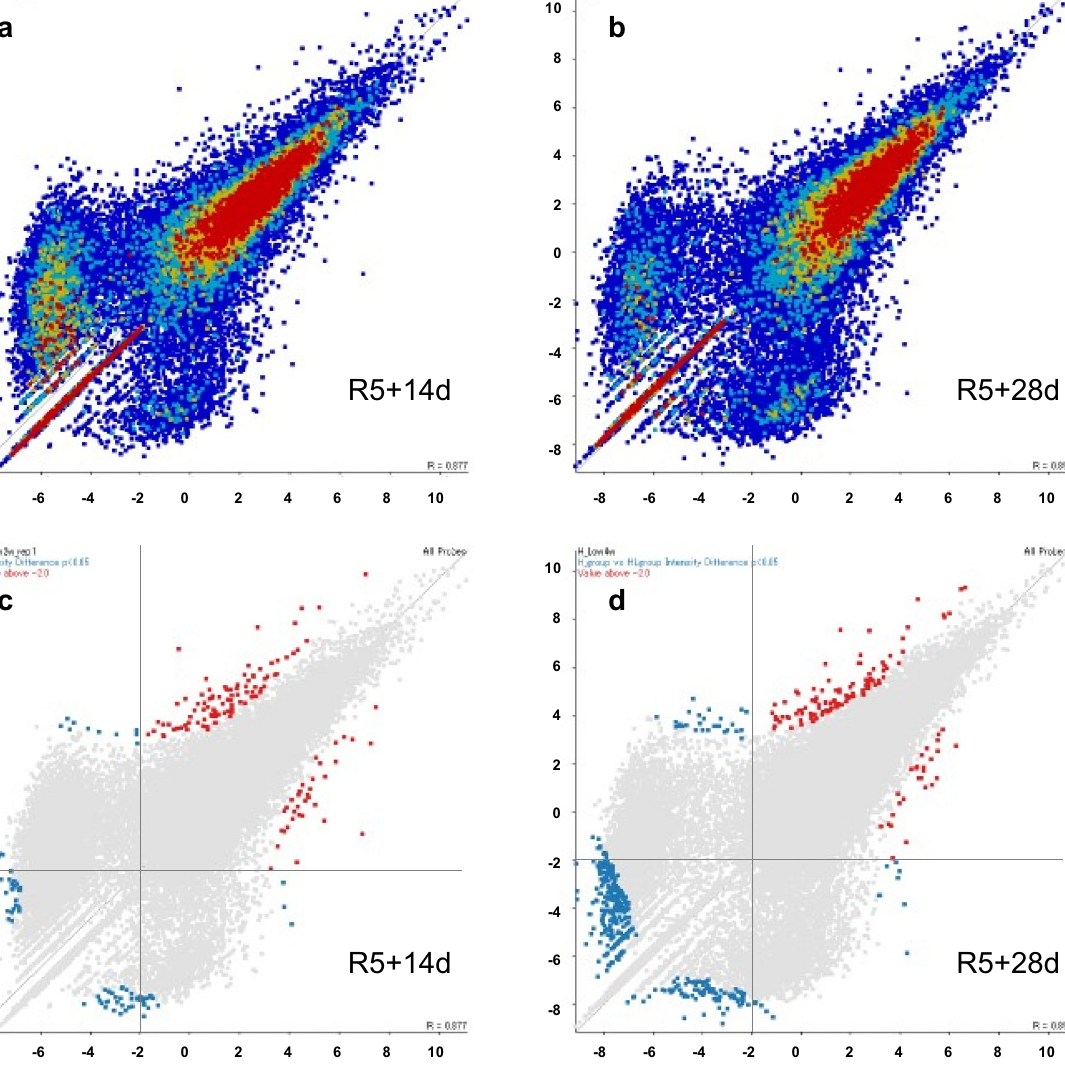
Figure 3. Scatter plots of all the differentially expressed genes (DEGs) in the stem identified by RNA-seq exposed to thinning and dense treatments. Vertical and horizontal axes represent mean expression level in plants exposed to the thinning and the dense treatment, respectively. One plot indicates one gene. ( a , b ) Scatter plot of all expressed genes at R5 + 14 d ( a ) and R5 + 28 d ( b ). Warm and cold colors in the plots indicate high and low overlapping levels, respectively. ( c , d ) Scatter plots of all DEGs at R5 + 14 d ( c ) and R5 + 28 d ( d ). Colored points indicate DEGs. Red colored points above the horizontal (y = − 2) and vertical lines (x = − 2) indicate the genes filtered using intensity difference test ( p < 0.05) and screened using a logarithmic value of > − 2.0. Figures were produced with the software SeqMonk v1.38.2 and Java